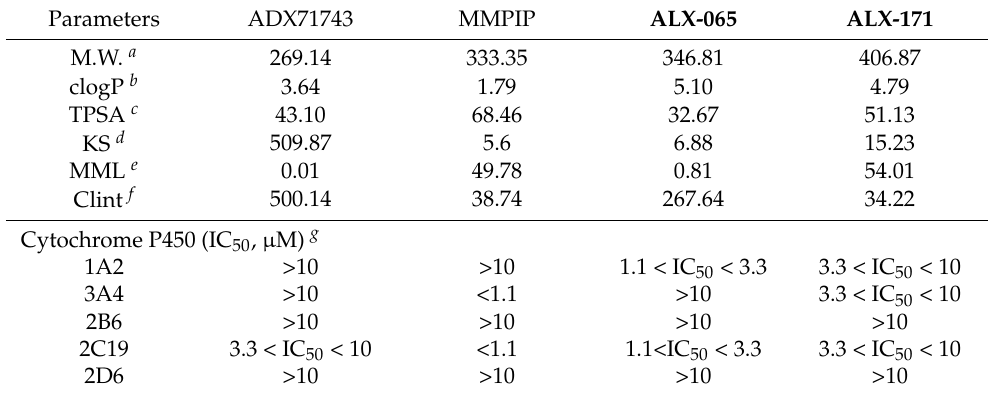
Table 4. Preliminary ADME